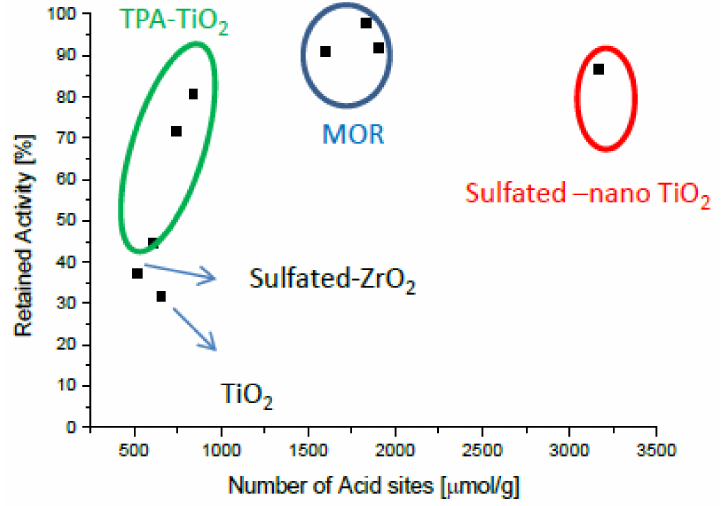
Figure 2. Retained activity at 400 ◦ C upon impregnation with 100 µ mol K g − 1 for V 2 O 5 /sulfated-ZrO 2 ) as a function of the number of acid sites of fresh catalysts. Generated with data from